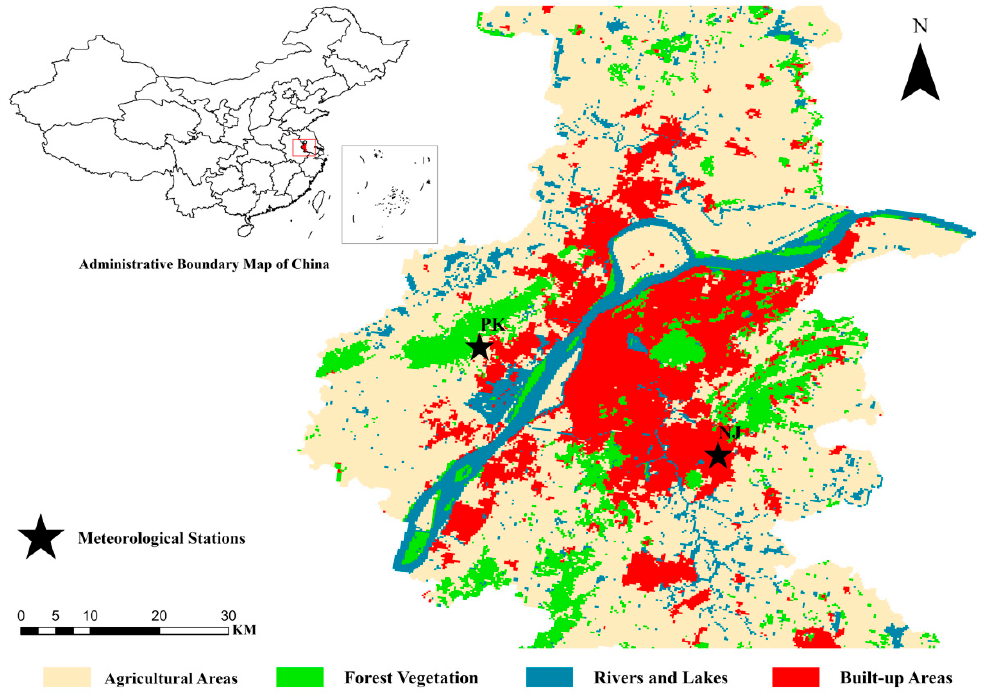
Figure 1. The study area and the locations of the two national meteorological stations in Nanjing, China (map based on the publicly available land use map provided on the website of the Nanjing Municipal Bureau of Land and Resources).